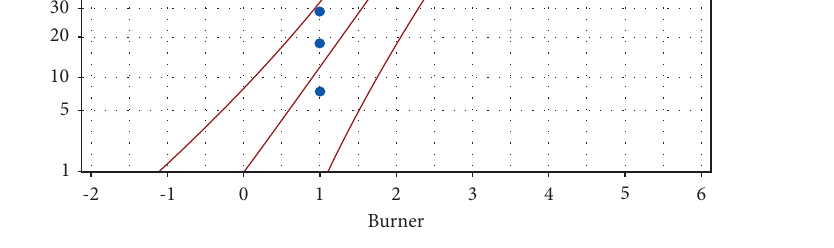
Figure 17: Residuals versus burner.